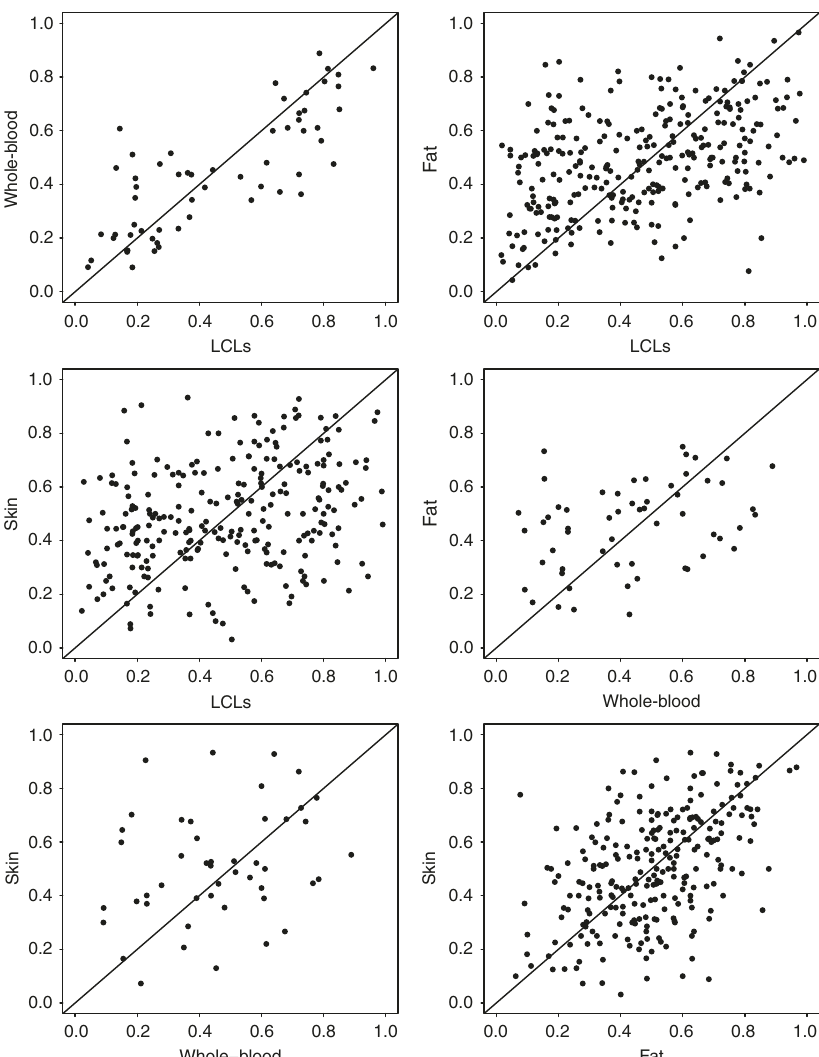
Fig. 3 Tissue – tissue comparison of XIST ASE reveals the highest similarity of XCI skew between blood tissues. Each plot shows the comparison of XIST ASE between two tissues from an individual. Each dot represents an individual. In each comparison all individuals with available XIST ASE calls for both tissues were included. Diagonal line indicates perfect concordance in the data ( ρ = 1). Table 2 Correlation of XCI skew varies between tissue pairs, and is highest between blood-derived tissues. Tissue LCLs Whole blood Fat Skin LCLs 1 0.78 [2e − 13] 0.42 [5e − 14]